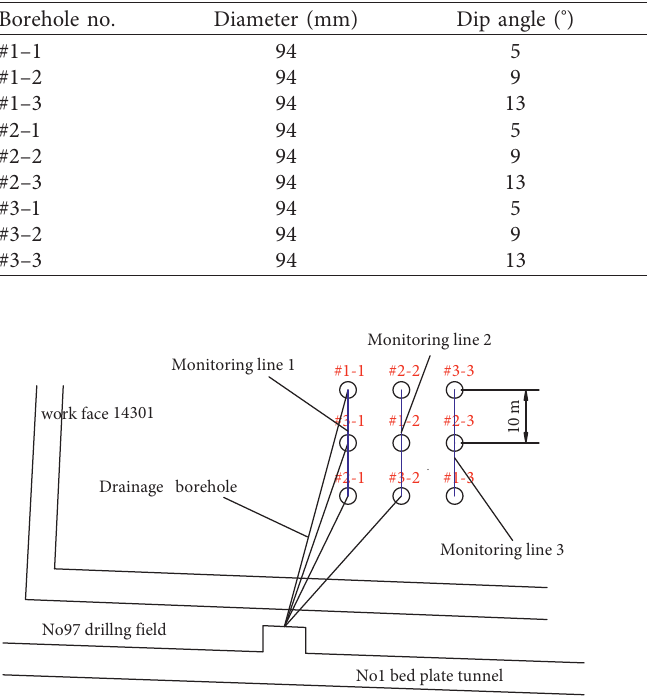
Table 4: Basic parameters of the experiment boreholes.